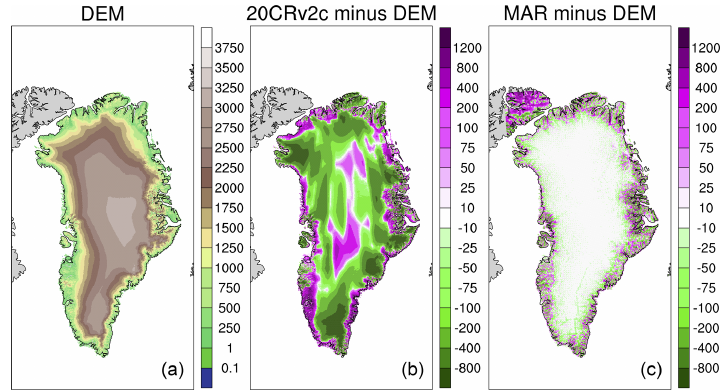
Figure 2. (a) Digital elevation model (DEM) of Bamber et al. (2013) interpolated to EASE 5km grid; (b) bias of 20CRv2c surface elevation field interpolated to EASE grid, relative to Bamber et al. (2013); (c) bias of MAR surface elevation field relative to Bamber et al. (2013). Units are meters.